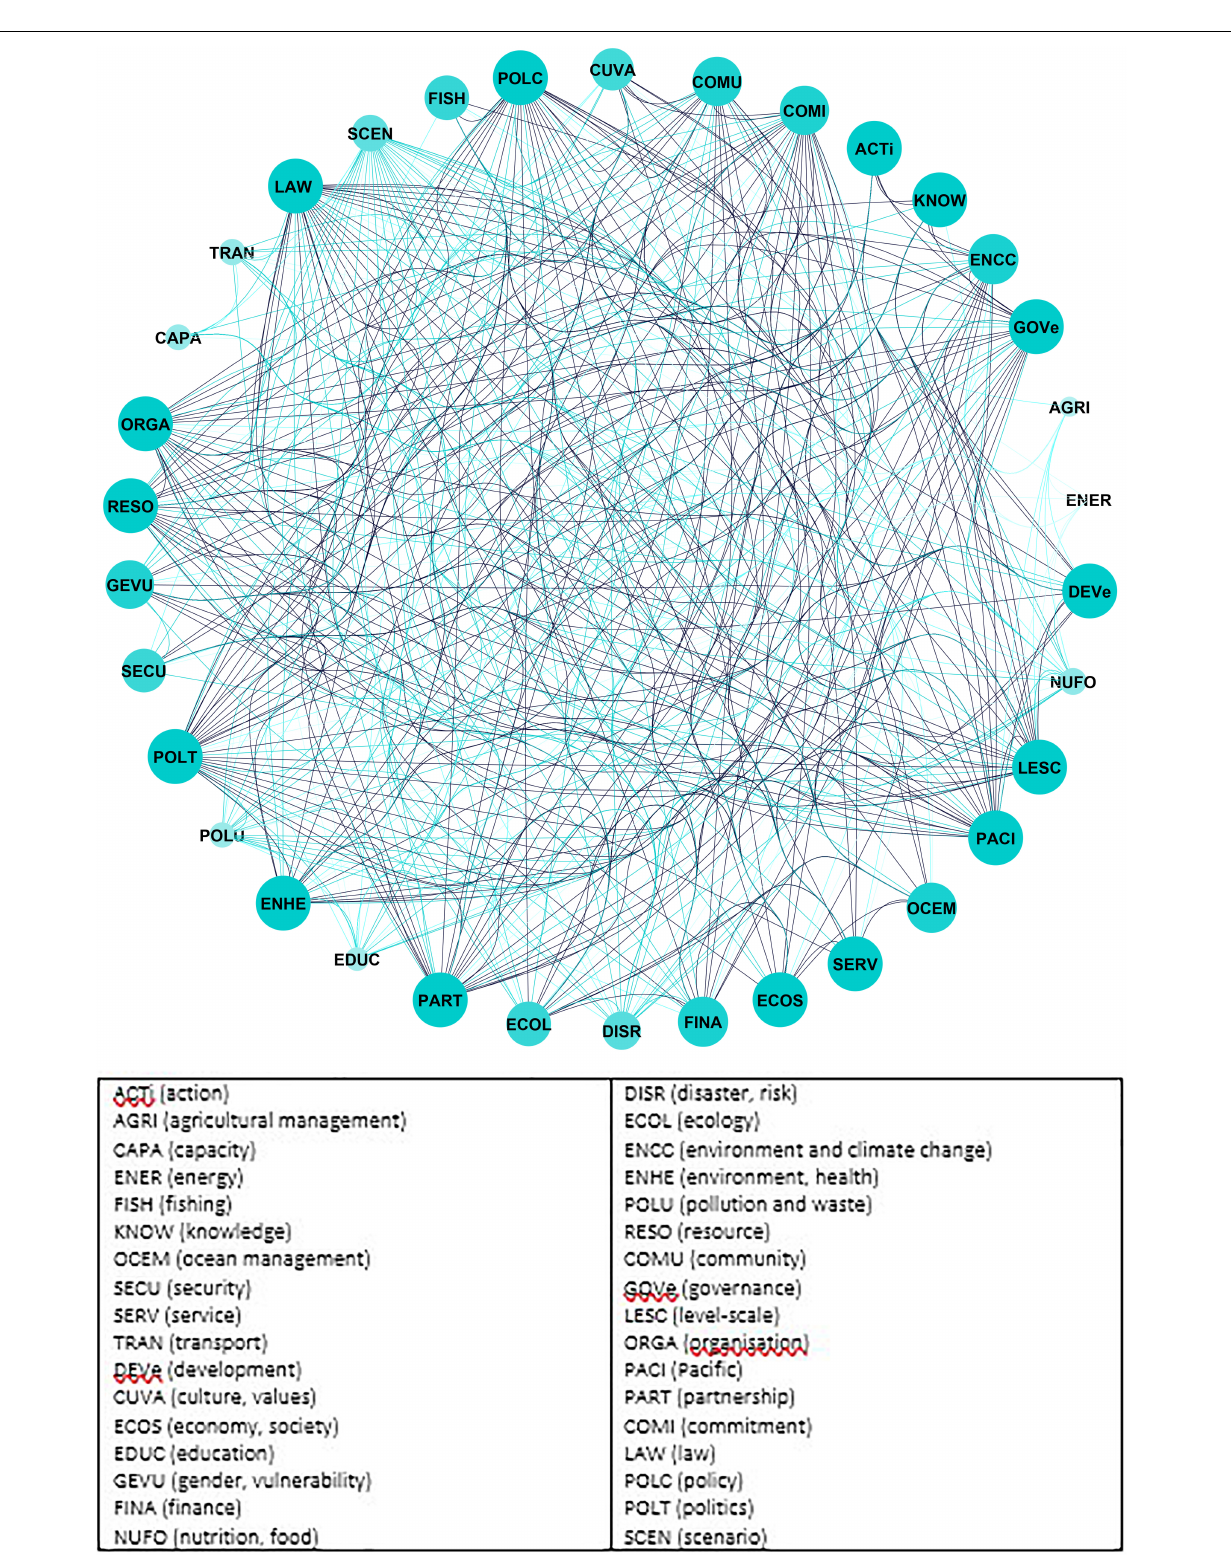
Frontiers in Marine Science |